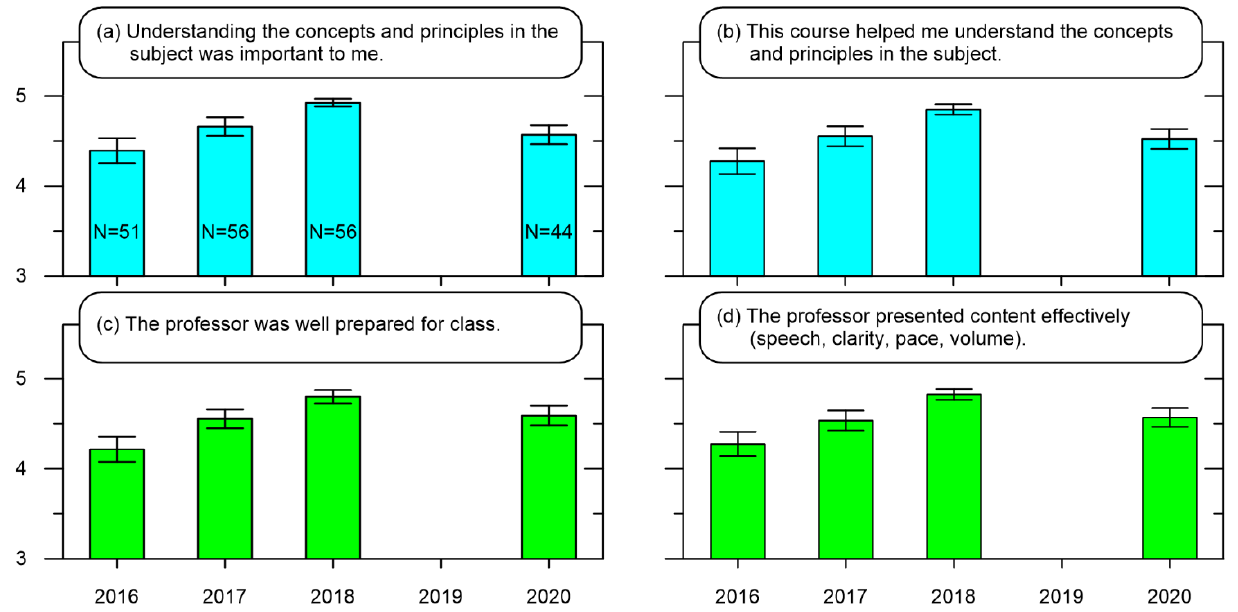
Figure 1. Compilation of course evaluation results for a 2020 first semester compulsory course